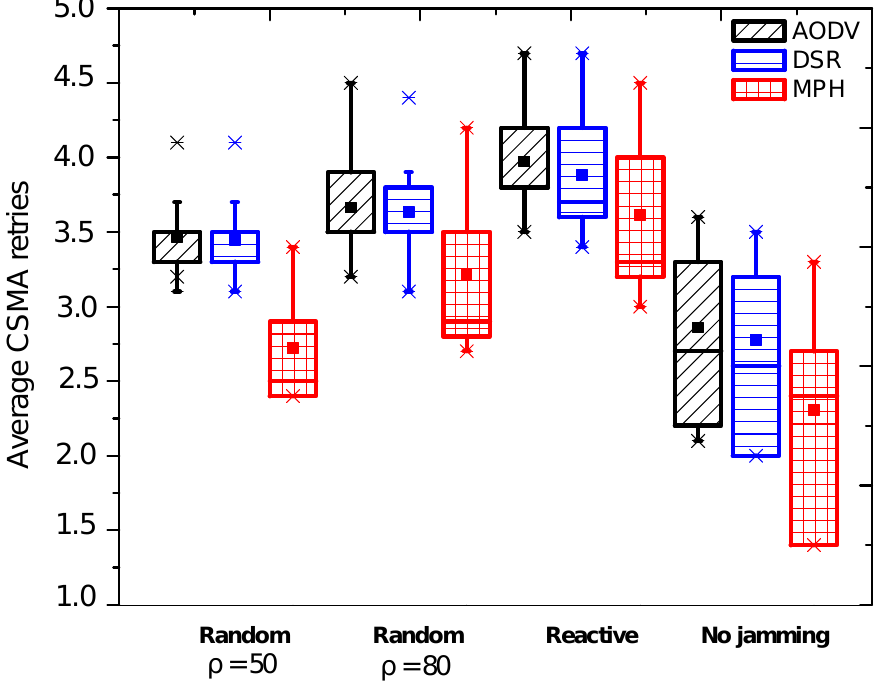
Figure 5. Average CSMA retries when the jammer node is in the middle of the